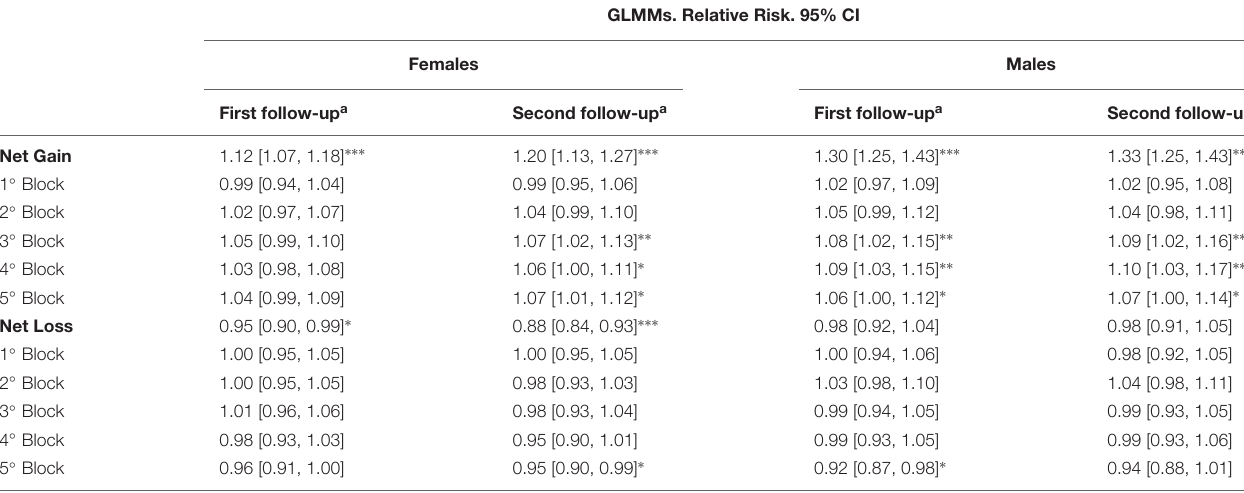
TABLE 4 | Developmental changes in females and males for gain and loss in each block. GLMMs. Relative Risk. 95% CI Females